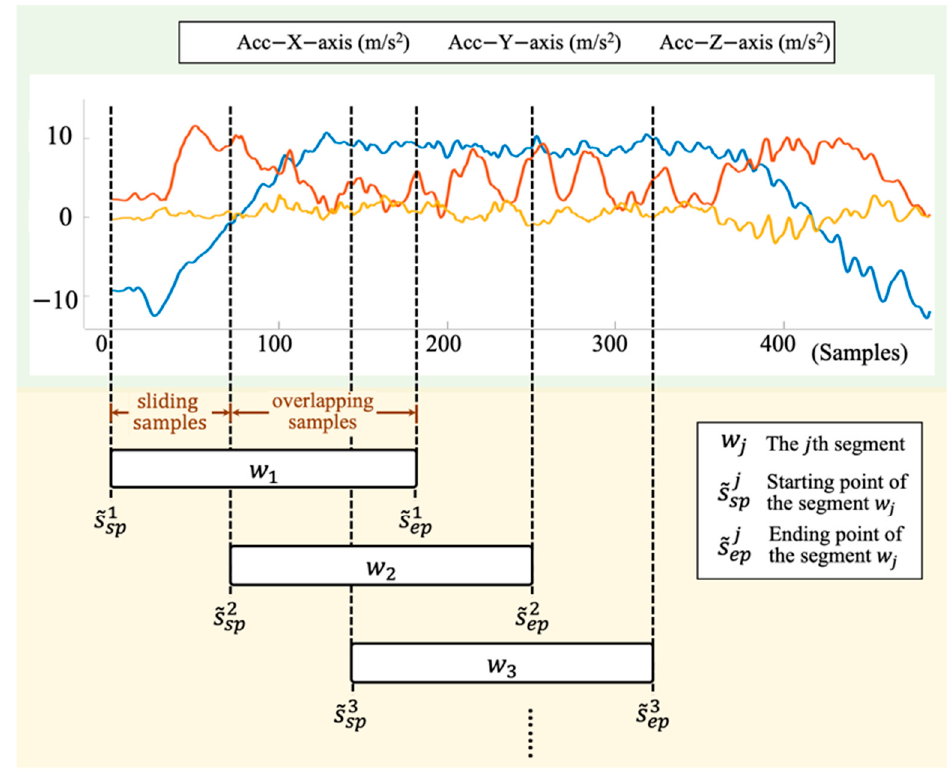
Figure 4. An illustration of the sliding window on the sensing signals. (cid:101) s j sp and (cid:101) s j ep are the starting and ending points of the segment w j , where j = 1,2, 3, . . . . The sliding samples is the distances from (cid:101) s j sp + 1 to (cid:101) s j sp . The overlapping samples is the number of the overlapping data samples between segments w j and w j + 1